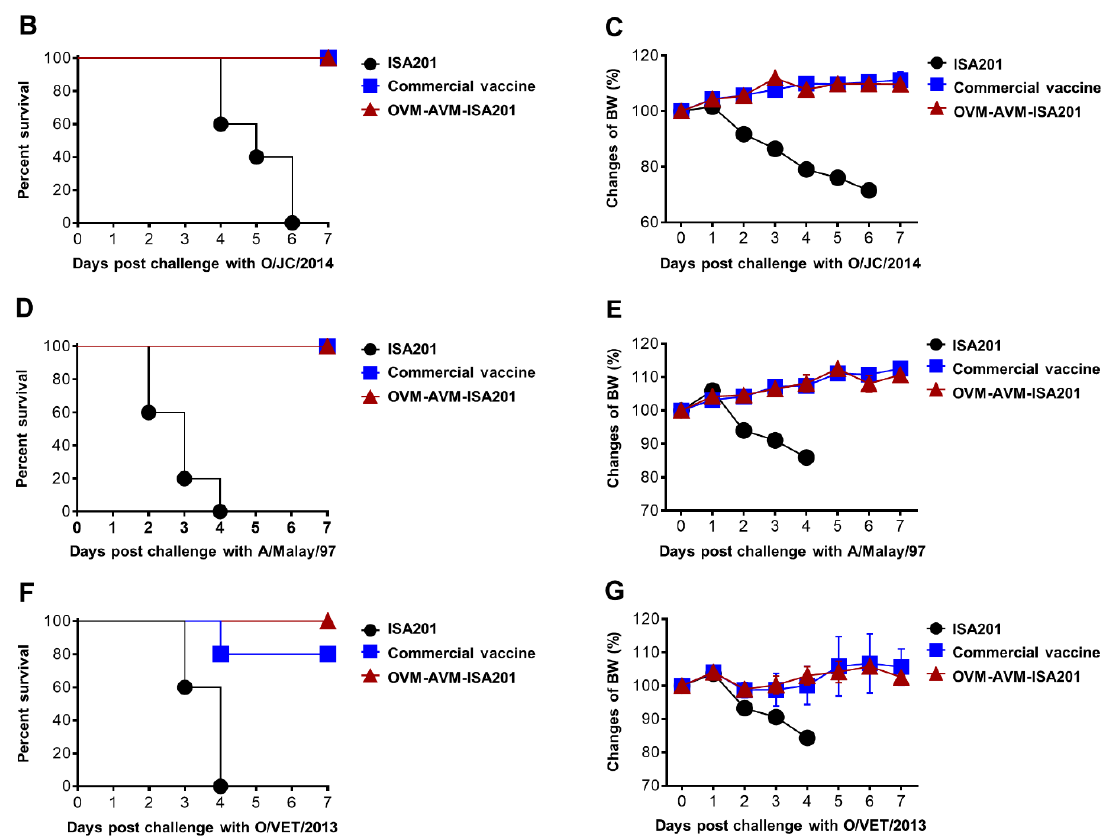
Figure 3. OVM-AVM-ISA201-mediated host defense against FMDV infection in mice. As the strategy depicted in Figure 3A, mice ( n = 5/group) were intramuscularly administered with 20 µ g of OVM and 20 µ g of AVM emulsified with ISA201. The positive control received (1/10 pig dose) commercial trivalent vaccine. The negative control received the same volume of ISA201. Vaccination was performed twice at a 14 day interval. Mice were challenged with 100 LD 50 of O/Jincheon/SKR/2014 (O/JC/2014), A/Malay/97, or O/Vietnam/GiaB ì nh/2013 (O/VET/2013) at 28 days post immunization (dpi). The survival rate and body weight were monitored for 7 days post challenge (dpc). ( A ) Schematic depiction of mouse experiment strategy. ( B ) Survival percentage. ( C ) Percentage of body weight changes after O/Jincheon/SKR/2014 challenge. ( D ) Survival percentage. ( E ) Percentage of body weight changes after challenge with A/Malay/97. ( F ) Survival percentage. ( G ) Percentage of body weight changes after challenge with O/Vietnam/GiaB ì nh/2013. The values are presented as mean ±